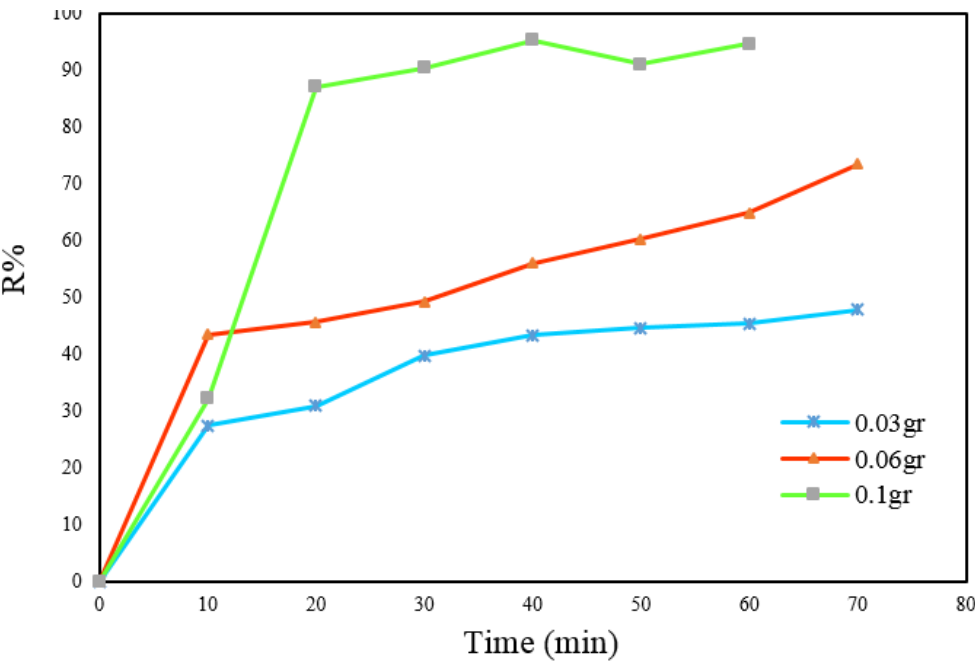
Fig. 13. Diagram of the effect of different concentrations nano composite on methylene blue degradation.